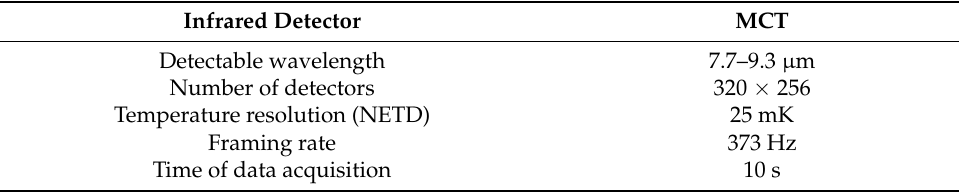
Table 1. Specifications and setting of employed infrared